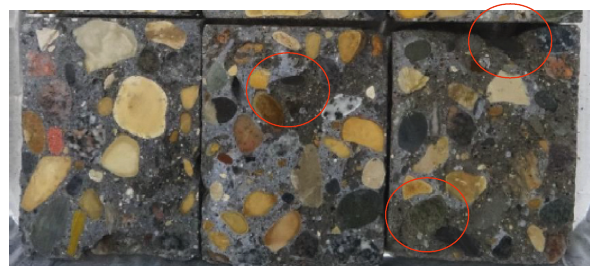
Figure 10: Samples exposed to MgCl right: 10%, 5%, and 0% silica fumes [23]; sample on right with no silica fume lost some aggregates during F-T. 2 : paste was pushed